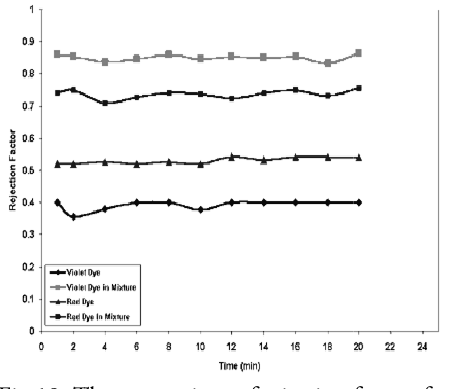
Fig.19. T The comparison of dyes (c concentration dyes) w with that of